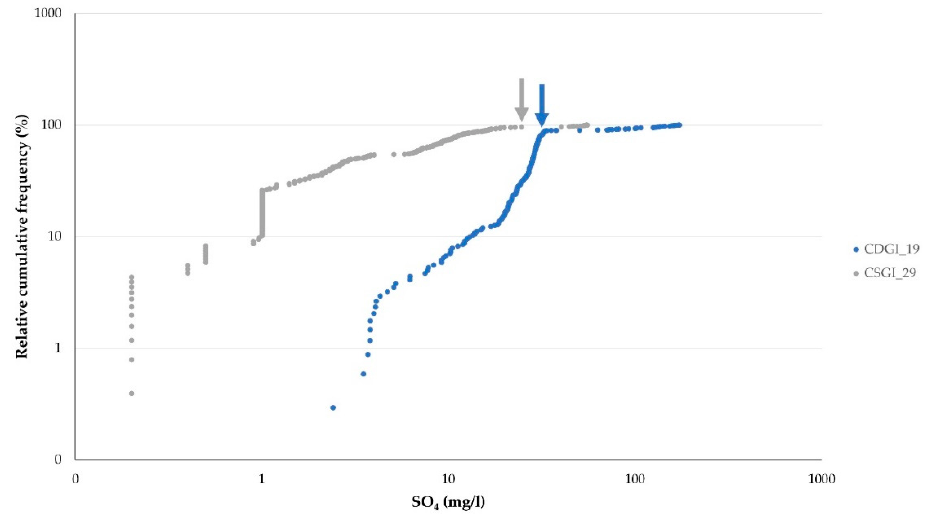
Figure 9. Cumulative relative frequencies of sulphate (SO 4 ) for groundwater bodies CDGI_19 and CSGI_29. Arrow indicates value x considered for the calculation of Mean + 2SD and Median + 2MAD ranges for each groundwater body.